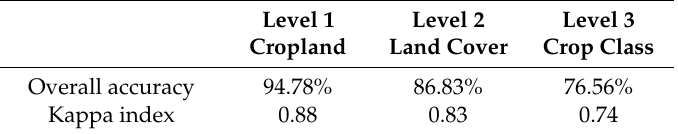
Table 3. Overall accuracy and Cohen’s kappa obtained for each level of the nomenclature.